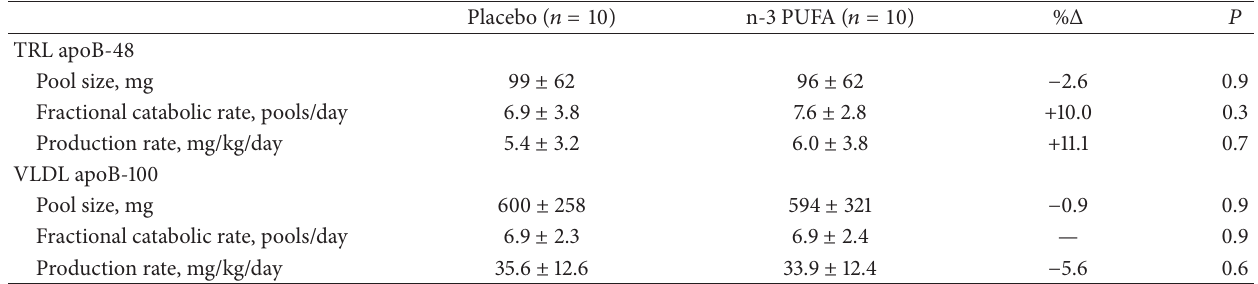
Table 2: Kinetic parameters of apoB-48 in TRL and apoB-100 in VLDL following supplementation with n-3 PUFA in patients with type 2